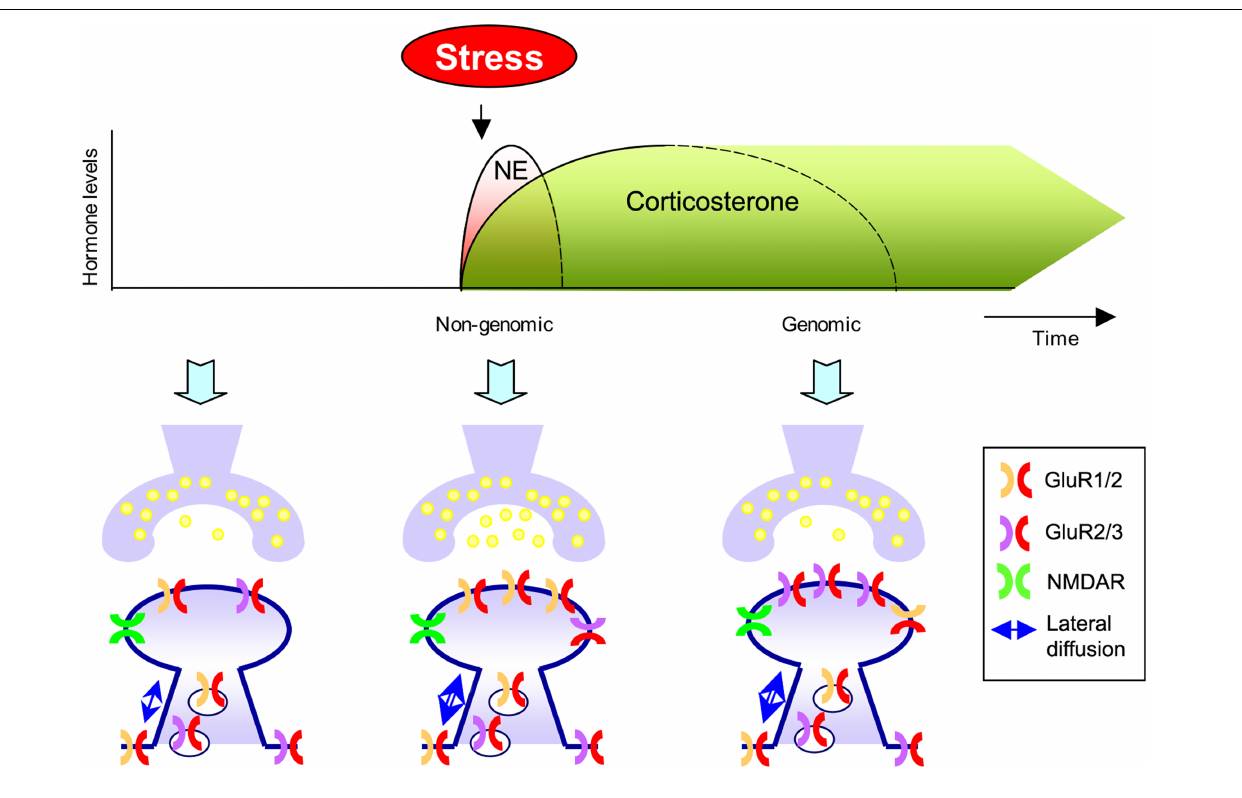
FIGURE 2 | Differential effects of stress hormones on AMPA receptor traffi cking. During the initial phase after stress exposure when norepinephrine (NE) are rapidly and reversible released activation of β -ARs and corticosteroid hormones via MRs modulate synaptic function; release probability, lateral diffusion, synaptic incorporation of GluR1/2 containing AMPA receptors,